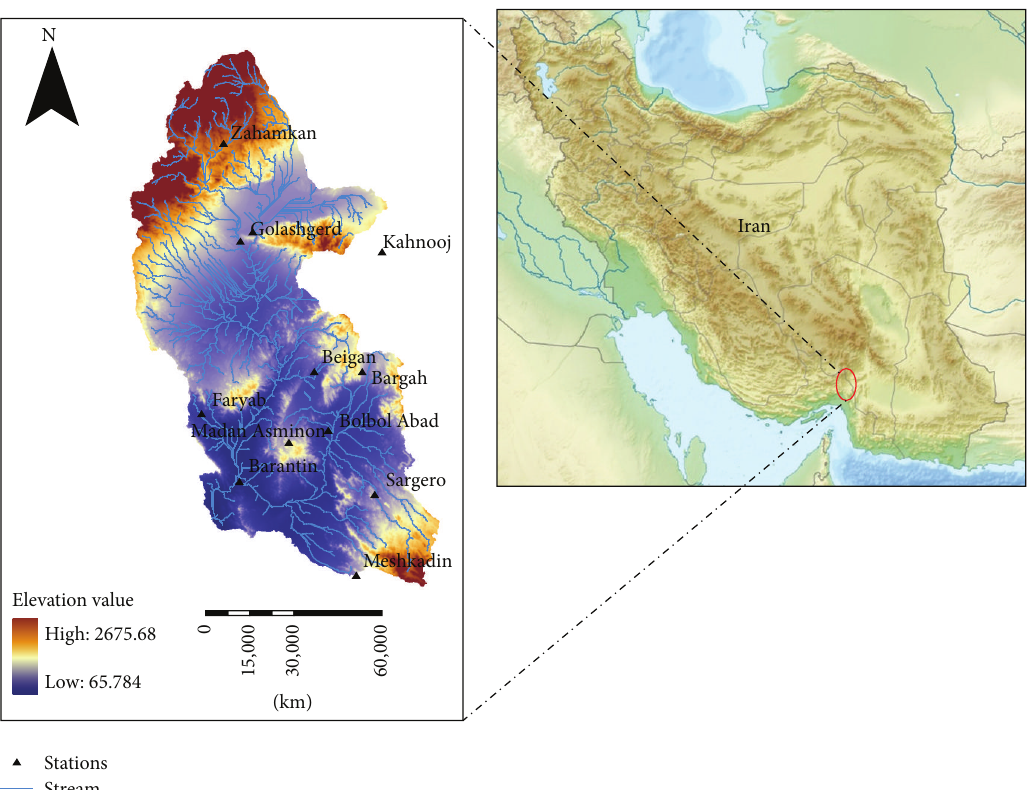
Figure 1: Visualization of meteorological stations and Roodan